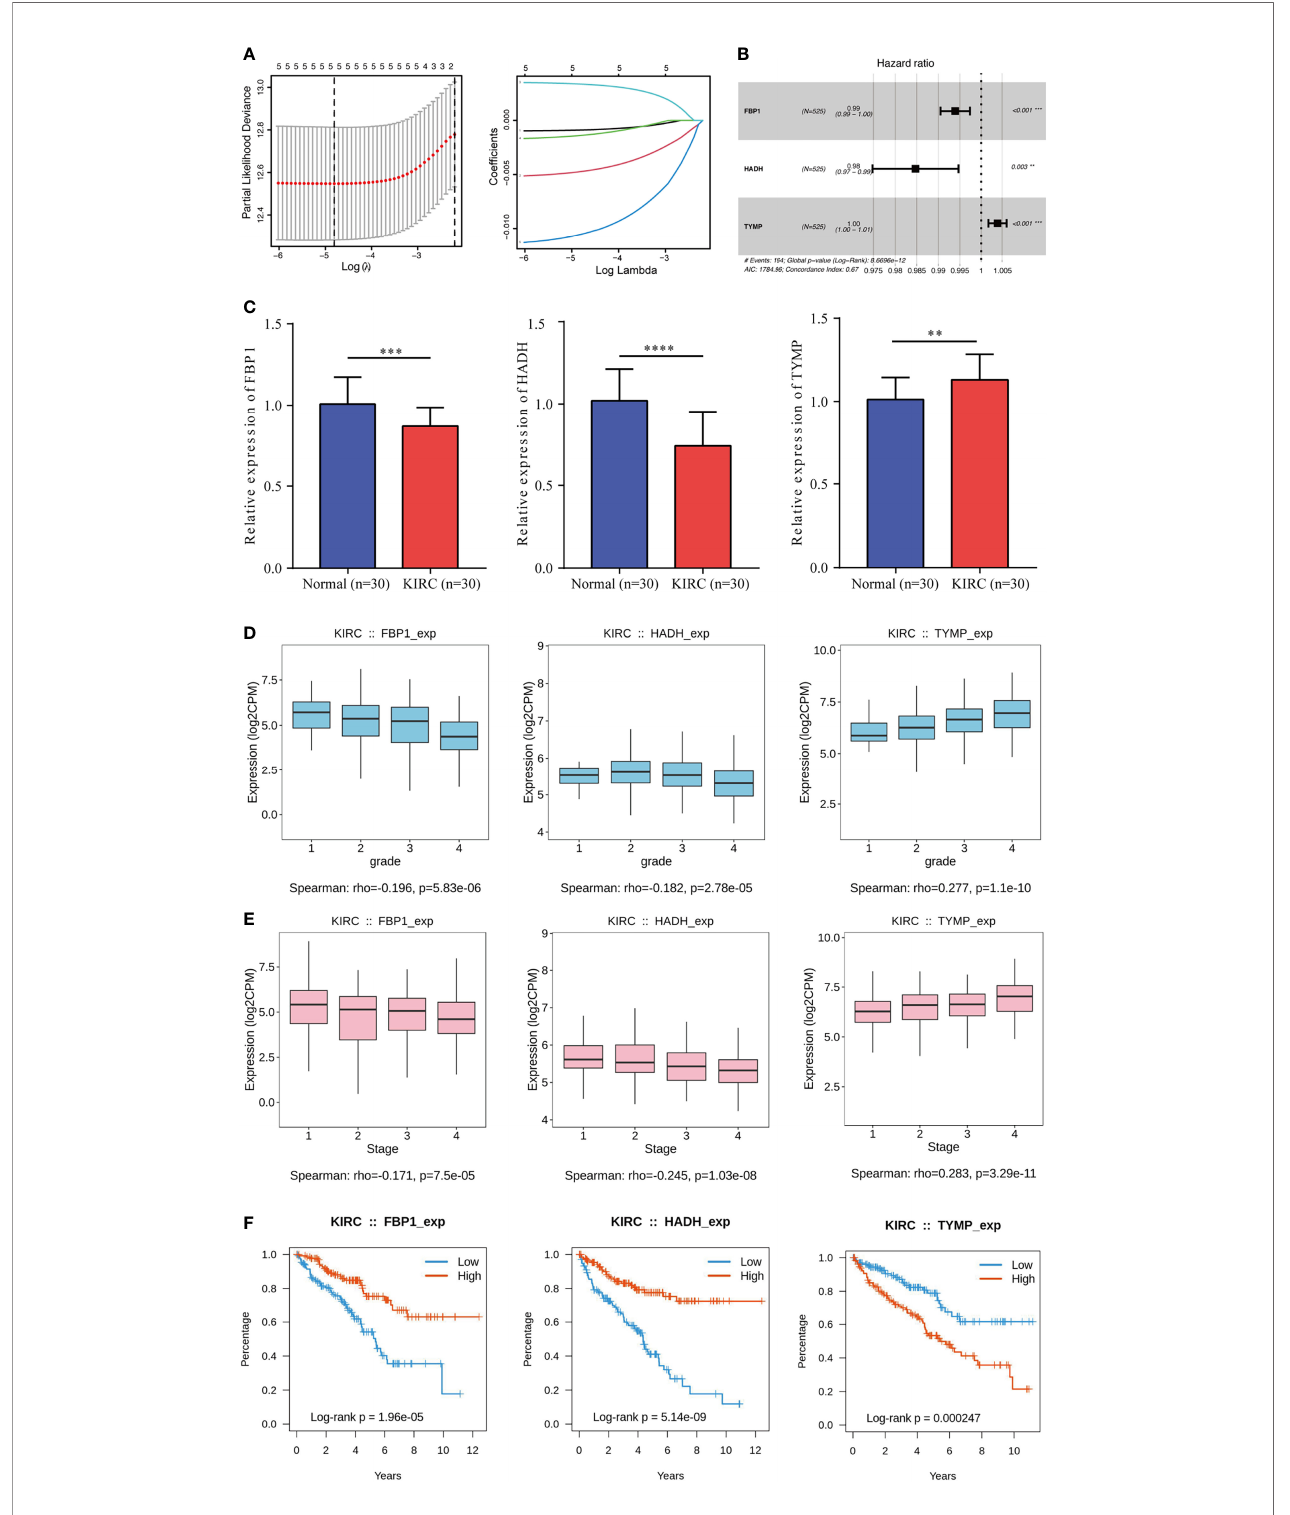
FIGURE 3 | Construction of a lactate-related prognostic signature (LRPS) in The Cancer Genome Atlas (TCGA) cohort. (A) Coef fi cient pro fi les of the six lactate- related genes (LRGs) and identi fi cation of the best parameter ( lambda ) in the LASSO (least absolute shrinkage and selection operator). (B) Three genes retained to construct the optimal LRPS using multivariate Cox analysis. (C) mRNA levels of three LRGs detected by qRT-PCR. (D, E) Correlations of the three LRGs in LRPS and tumor grade (D) and tumor stage (E) . (F) Kaplan – Meier survival analysis of the three LRGs in LRPS. ** p < 0.01, *** p < 0.001, **** p <